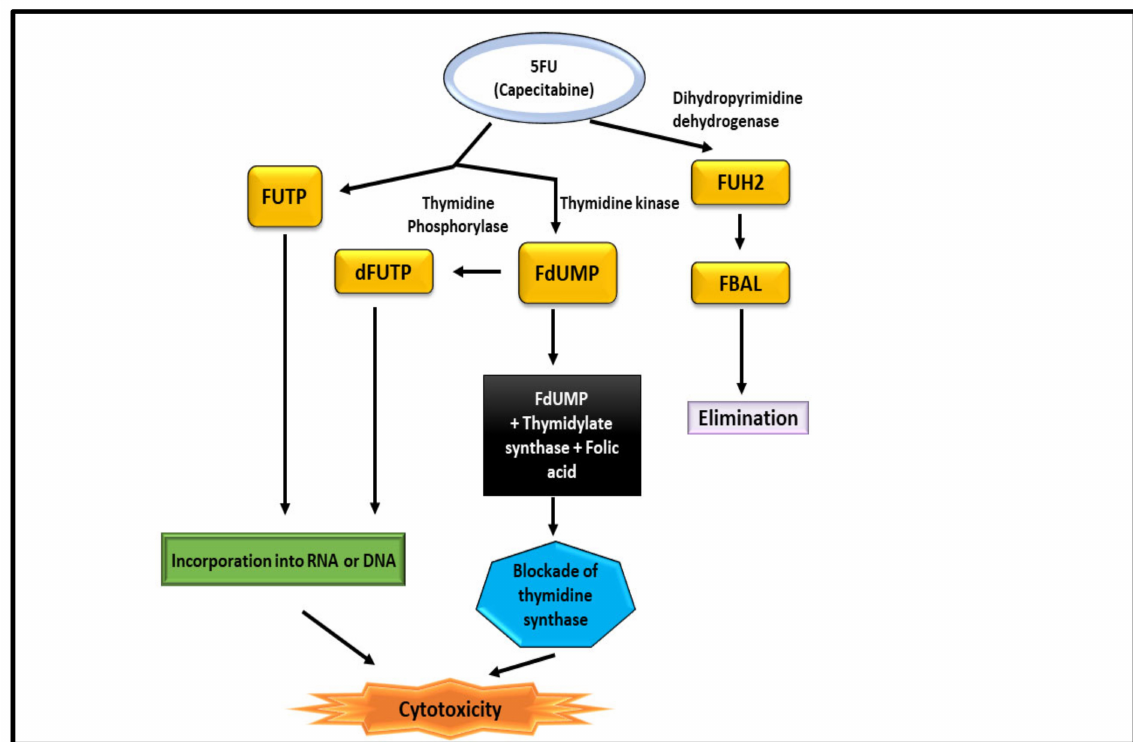
Figure 9. Mechanism of 5-FU for the treatment of